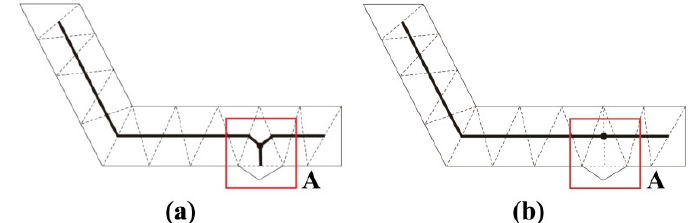
Figure 8. Spike jitter adjustment algorithm: ( a ) spike jitter and ( b ) adjustment result of spike jitter.